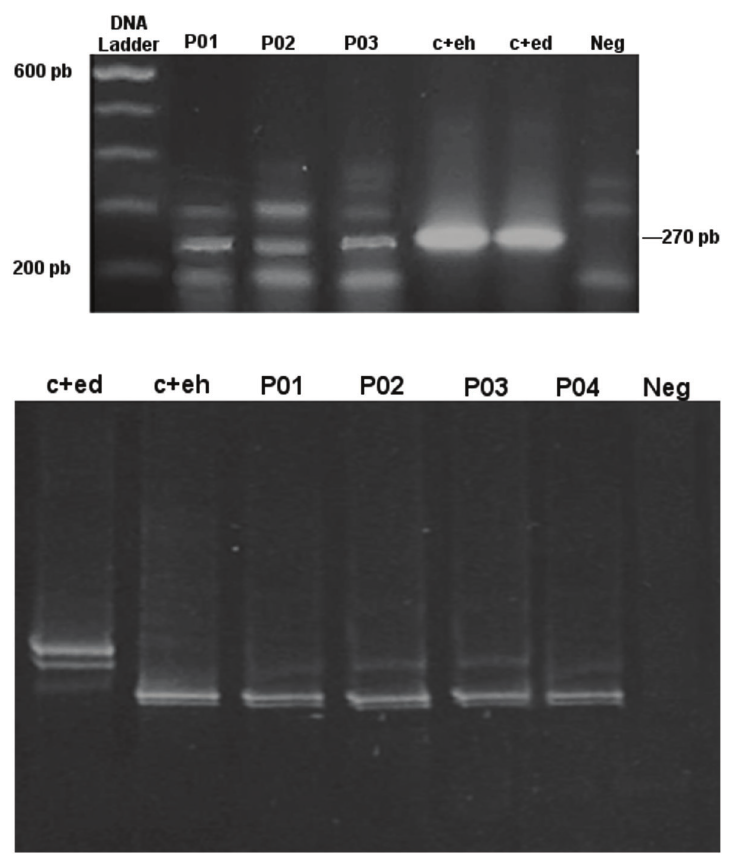
Figure 2. Stained agarose gel with products ampli fi ed by PCR with designed primers from